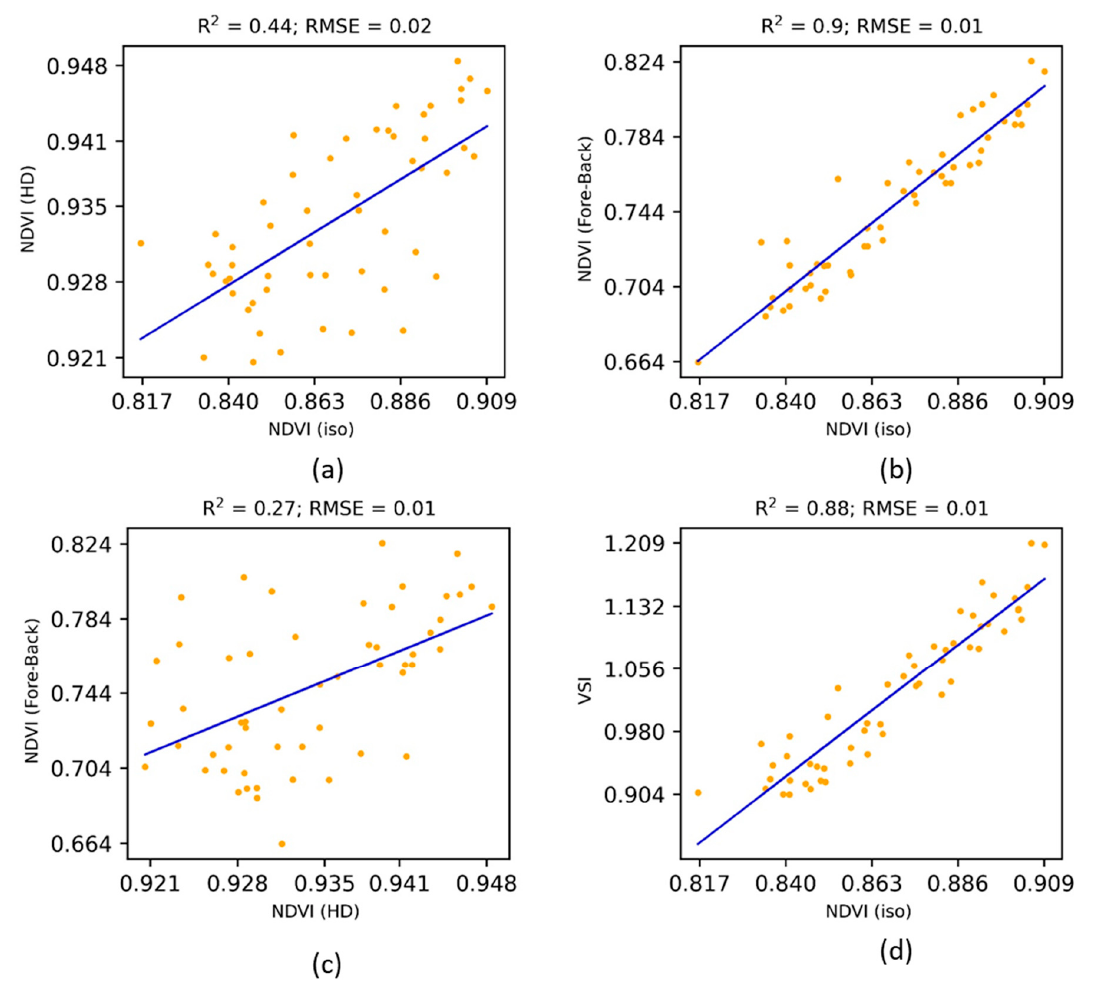
Figure 7. Interrelationships between multi-angular indices